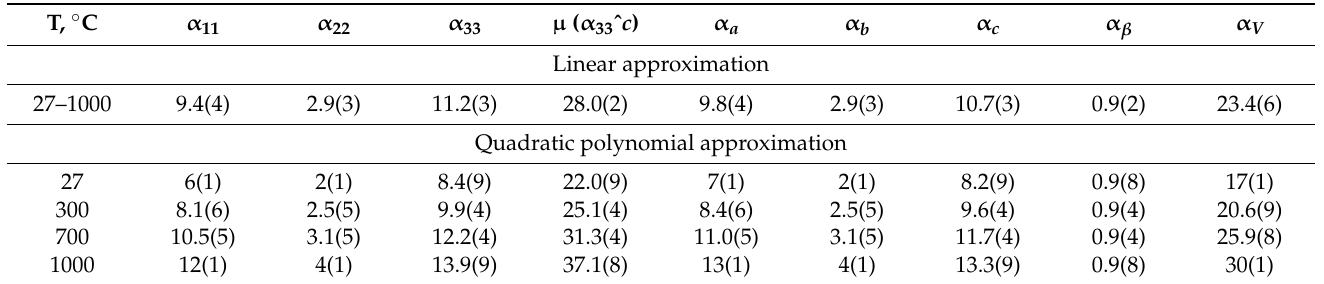
Table 5. TECs ( × 10 6 ◦ C − 1 ) of slawsonite along the principal axes of the thermal expansion tensor and crystallographic axes.